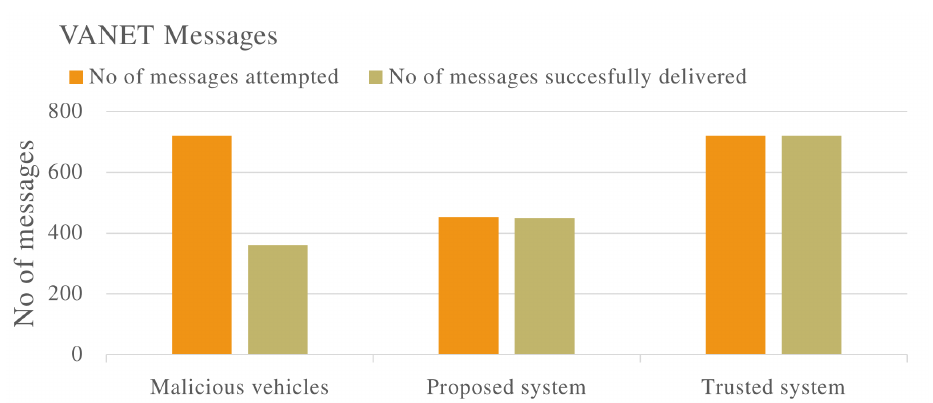
Figure 5. Total messages transmitted in VANET in multiple scenarios including malicious vehicles that are dropping packets in the VANET.